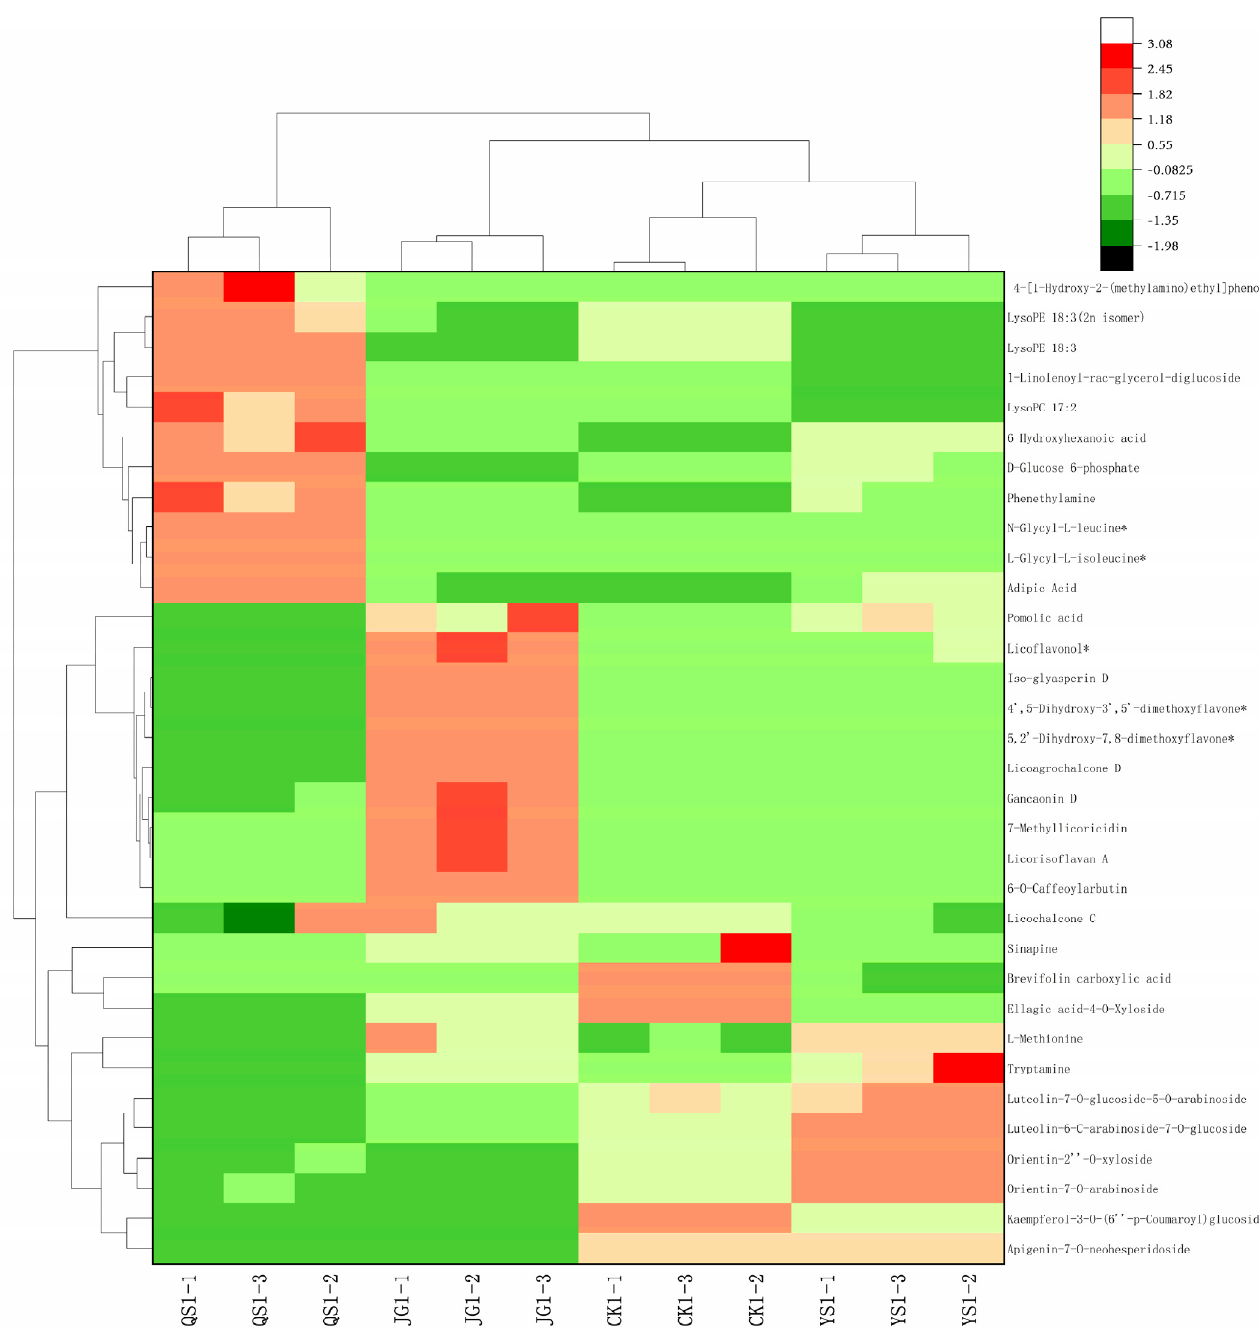
Figure 6. Heatmap of the hierarchical analysis of the 33 differential metabolites screened.